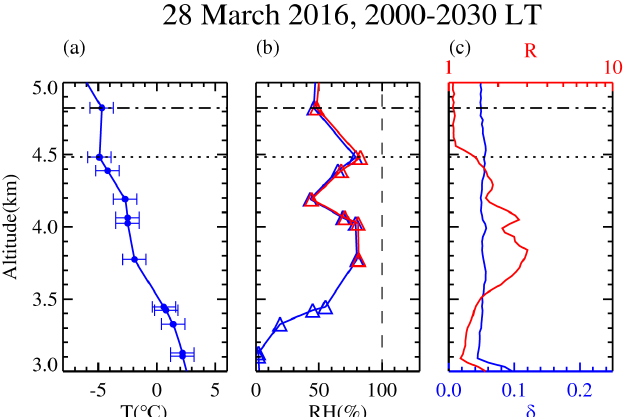
Figure 7. Profiles of ( a ) temperature T, ( b ) relative humidity over liquid water RH (blue) and over ice (red), measured by radiosonde launched around 2000 LT on 28 March 2016, ( c ) backscatter ratio (red) and depolarization ratio (blue) obtained by the polarization lidar during 2000–2030 LT on the same day. An inversion layer was marked by dotted